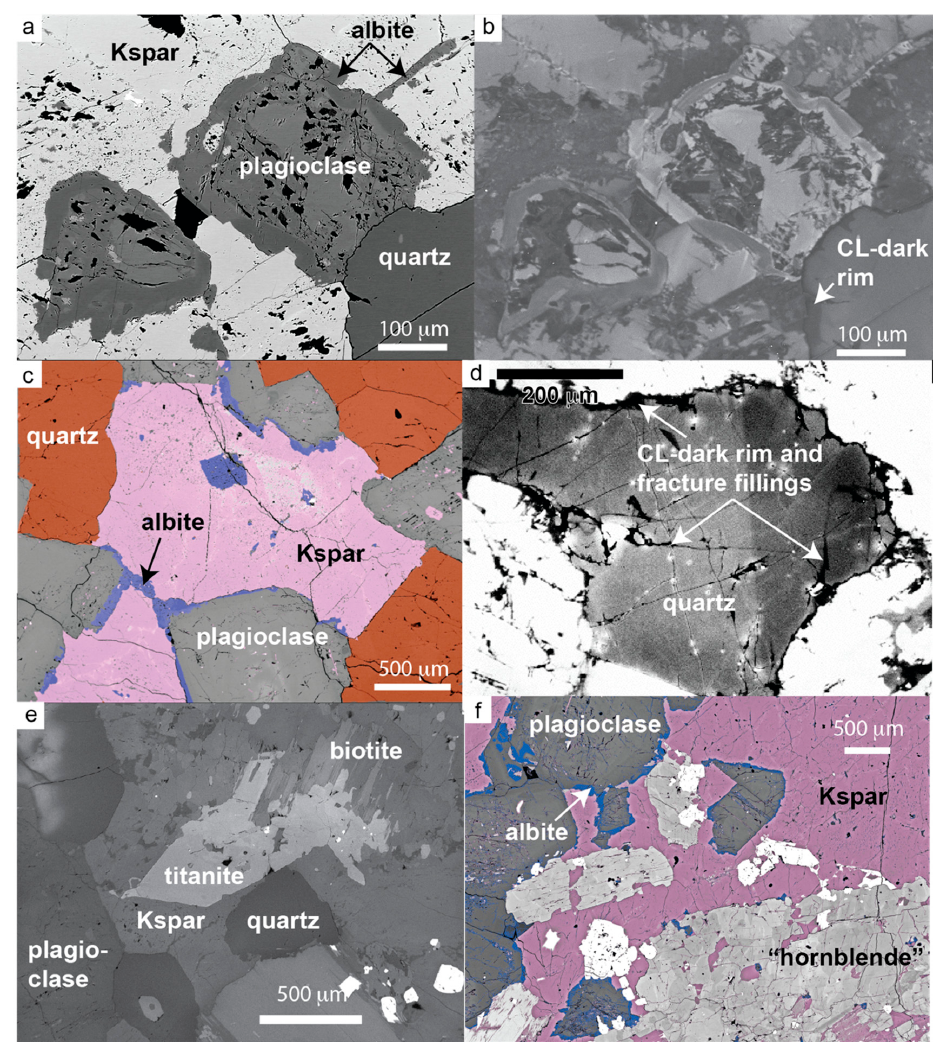
Figure 5. Backscattered electron (BSE) and cathodoluminescence (CL) images showing evidence of grain-scale modification by fluid infiltration. ( a ) BSE image of leucogranite, Tuolumne Intrusive Suite. BSE-dark albite selvages everywhere separate plagioclase from K-feldspar. ( b ) CL image of the same area as ( a ). Irregular patchy zoning of both feldspars reflects fracture, infiltration, and healing. The CL-dark (Ti-poor, low-temperature) rim on quartz reflects precipitation from grain-boundary fluid. ( c ) False-colored BSE image of Half Dome Granodiorite, Tuolumne Intrusive Suite, again showing albite along plagioclase-K-feldspar grain boundaries and locally within K-feldspar. ( d ) CL image of Alta Granodiorite, Utah [34]. CL-dark quartz rim and fracture fillings record precipitation from infiltrating fluid. ( e ) BSE image of Alta Granodiorite. Cores of euhedral titanite grains yield U-Pb dates of 36-31 Ma in agreement with U-Pb zircon dates from the same samples, whereas rims of euhedral grains and anhedral titanite intergrown with biotite give U-Pb dates as young as 23 Ma [13]. See text and reference [13] for further details. ( f ) False-colored BSE image of Half Dome Granodiorite. In addition to albite selvages, this image shows patchy zoning of “hornblende”, which actually ranges in composition from hornblende to actinolite and records greenschist facies replacement (see text and ref. [35] for petrological